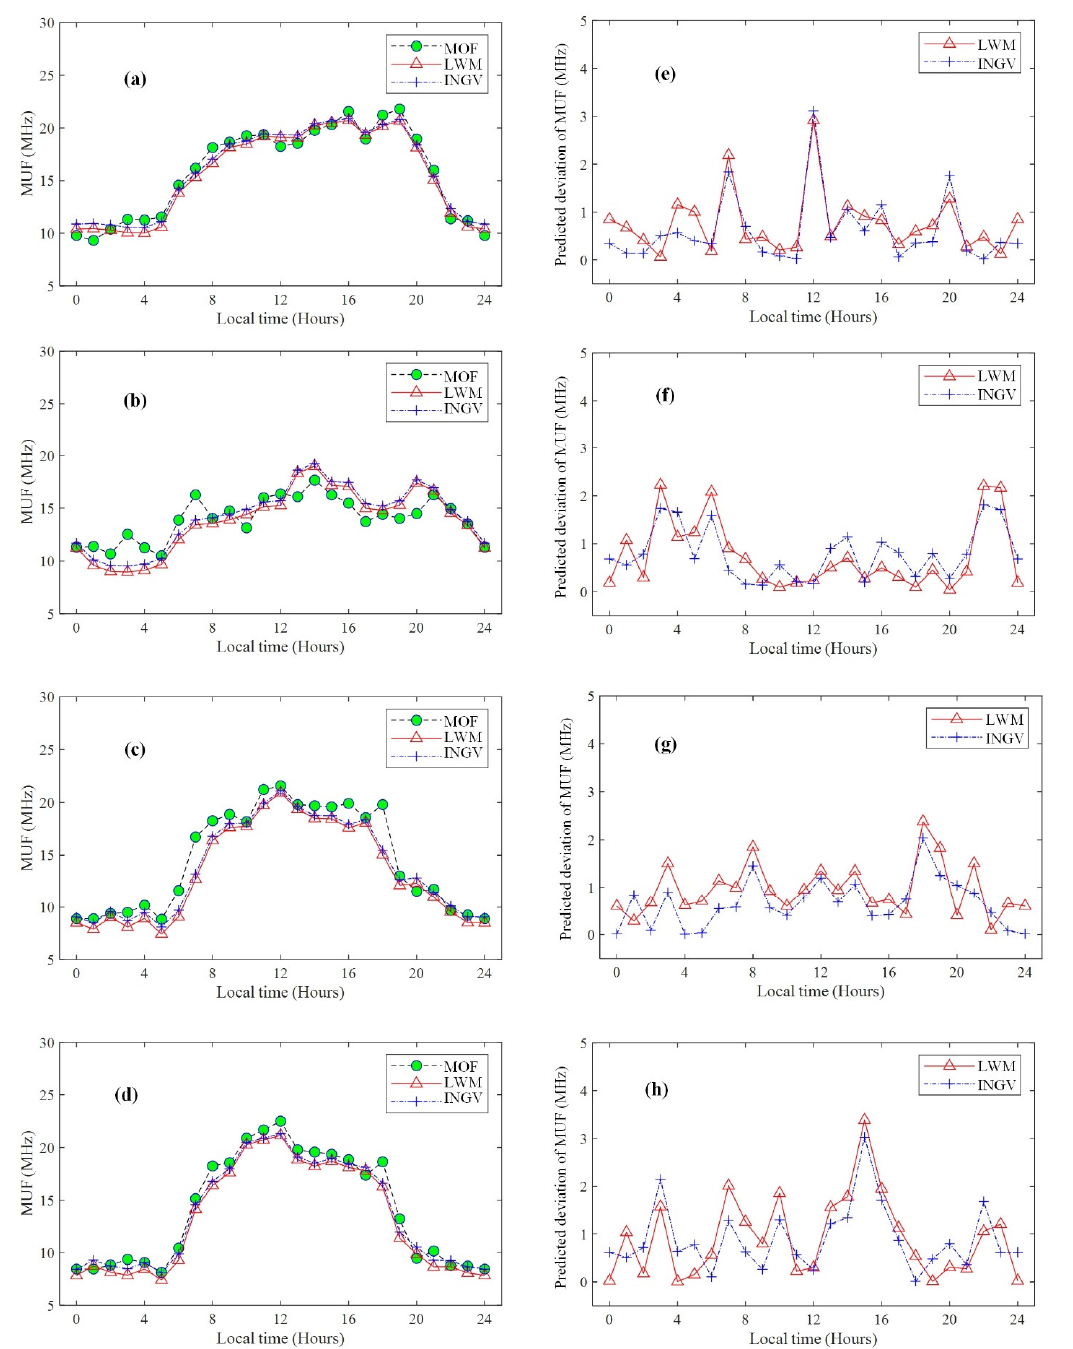
Figure 4. Comparison of MOF observations and MUF calculations from the LWM and INGV: ( a ) MOF and MUF calculations on 25 March 2016 (spring); ( b ) MOF and MUF calculations on 21 August 2016 (summer); ( c ) MOF and MUF calculations on 8 October 2016 (autumn); ( d ) MOF and MUF of on 25 December 2016 (winter); ( e ) Predicted deviation of MUF on 25 March 2016 (spring); ( f ) Predicted deviation of MUF on 21 August 2016 (summer); ( g ) Predicted deviation of MUF on 8 October 2016 (autumn); ( h ) Predicted deviation of MUF on 25 December 2016 (Winter).